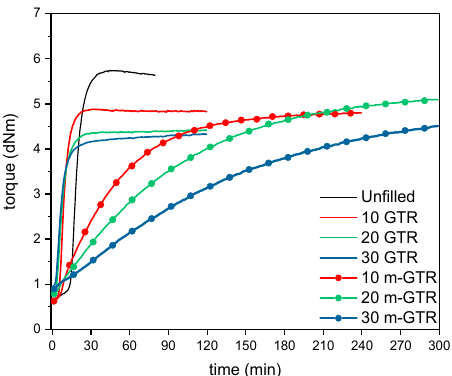
Figure 7. Rheometric curves of SBR, SBR–GTR, and SBR–m-GTR composites. Table 5. Rheometric properties of SBR–GTR and SBR–m-GTR composites. Composite